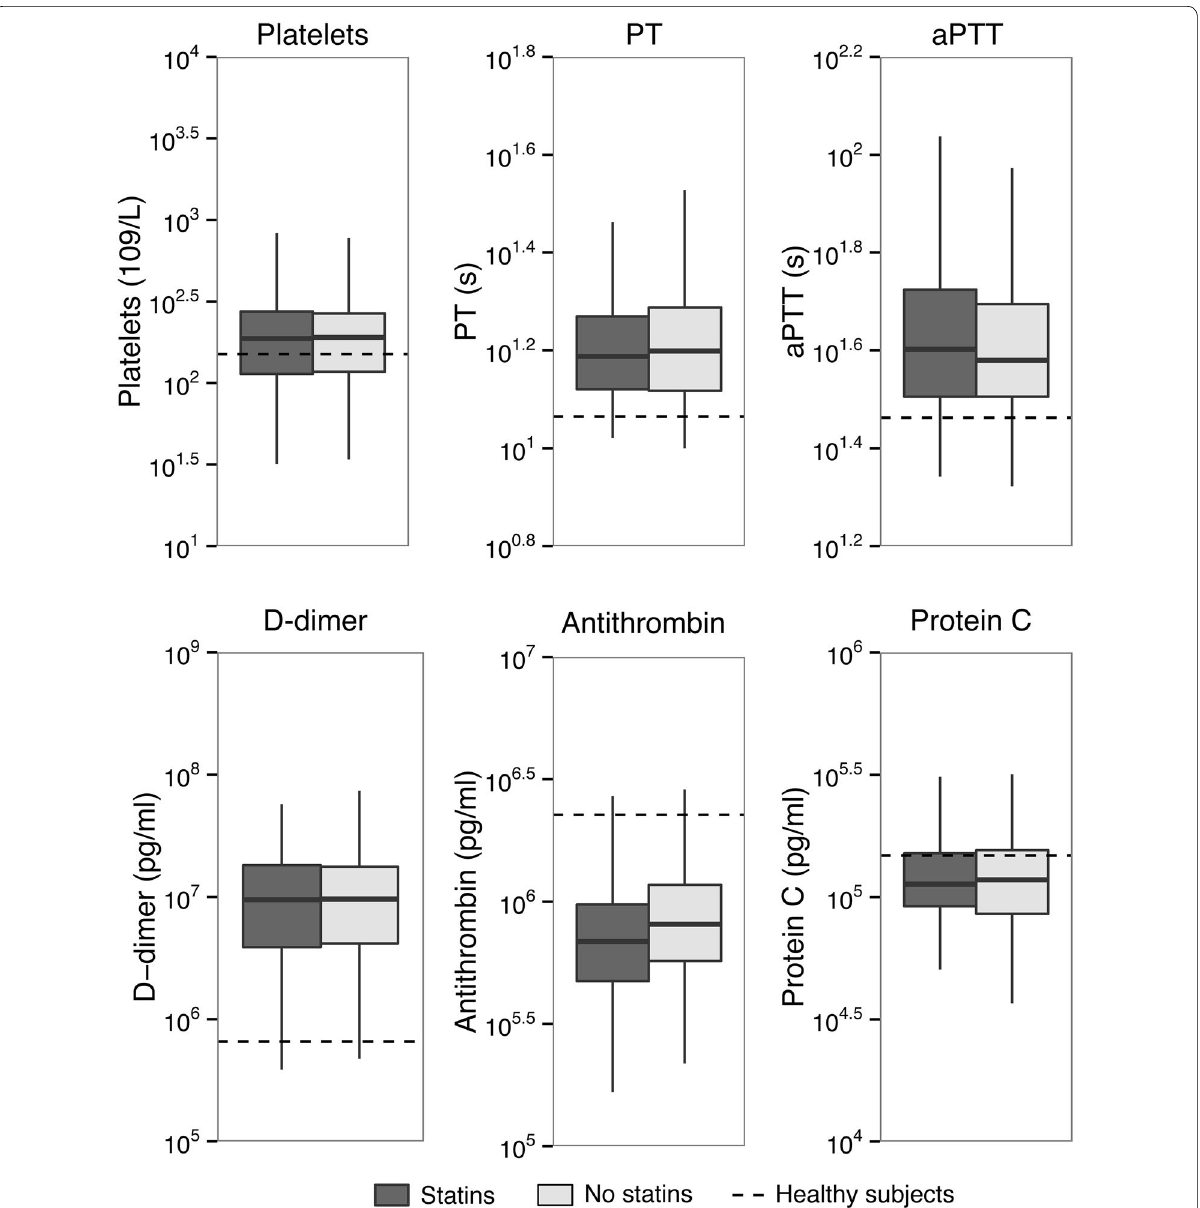
Fig. 3 Coagulation activation in sepsis patients on ICU admission stratified according to statin use in the propensity-matched cohort. Data are expressed as box-and-whisker diagrams depicting the median and lower quartile, upper quartile and their respective 1.5IQR as whiskers (as speci- fied by Tukey). Dashed lines represent median levels in 27 healthy volunteers, except for platelets, prothrombin time and activated partial throm- boplastin time, which represents the clinical laboratory lower and upper reference values, respectively. APTT was missing in 127 cases, PT in 10 and platelet count in 1 patient. Differences between groups were not